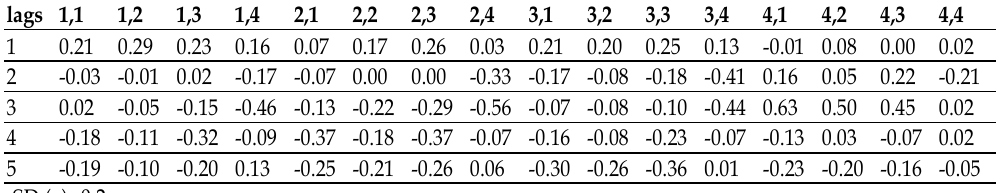
Table 6. Cross Correlation residual Function values (CCF). Road Infrastructure Capital Stock